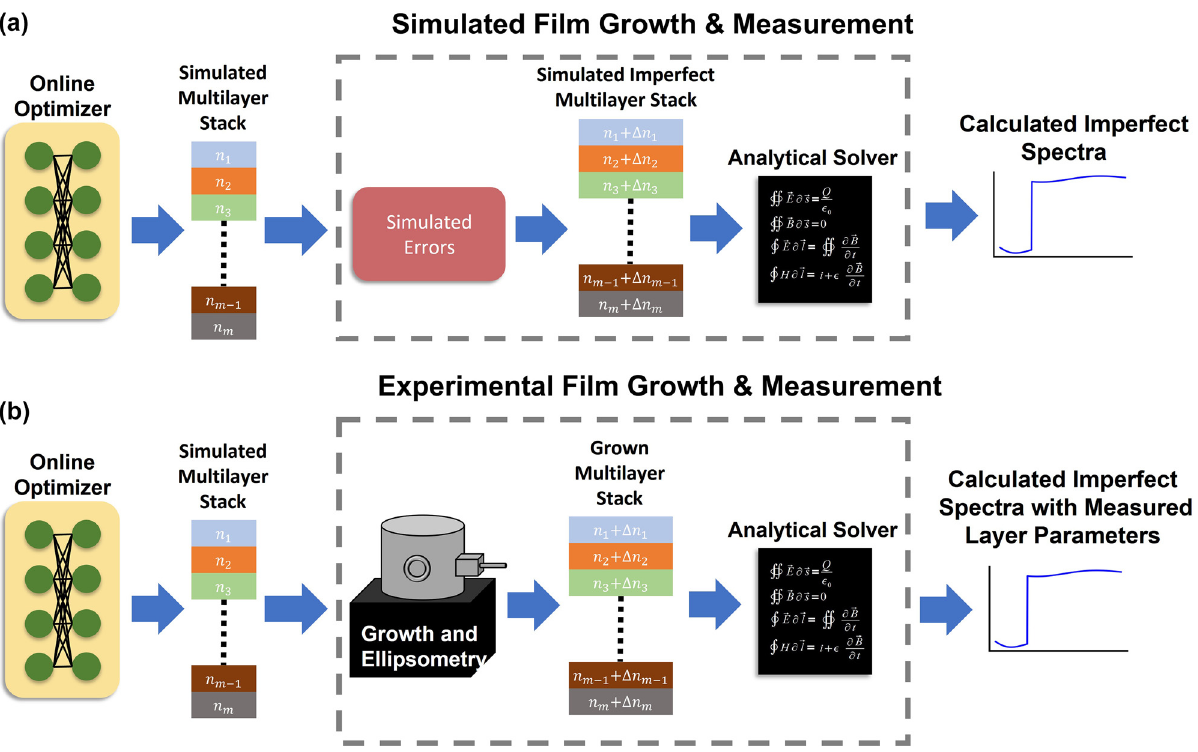
Figure 8: Network architecture for fabrication-in-loop NN-based inverse design of single-material multilayer optical stacks with continuously changing refractive index. (a) The optimization starts under ideal conditions and iterates until convergence. Later, fabrication-related imperfections are added to the ideally produced stack to simulate the imperfections from deposition tools. Modified stack response is calculated and the loss is backpropagated to update NN parameters. This procedure simulates the practical fabrication, (b) case. After ideal optimization, optimized parameters are used to grow the desired multilayer film. The imperfectly grown film will be measured and experimentally retrieved layer parameters are integrated back into the optimization cycle to calculate the imperfect response and loss function. This allows direct integration of imperfections related to the growth process into the optimization loop without disrupting the backpropagation chain. Simulated errors replace the film growth and ellipsometry in the optimization process for the experimental realization of the multilayer